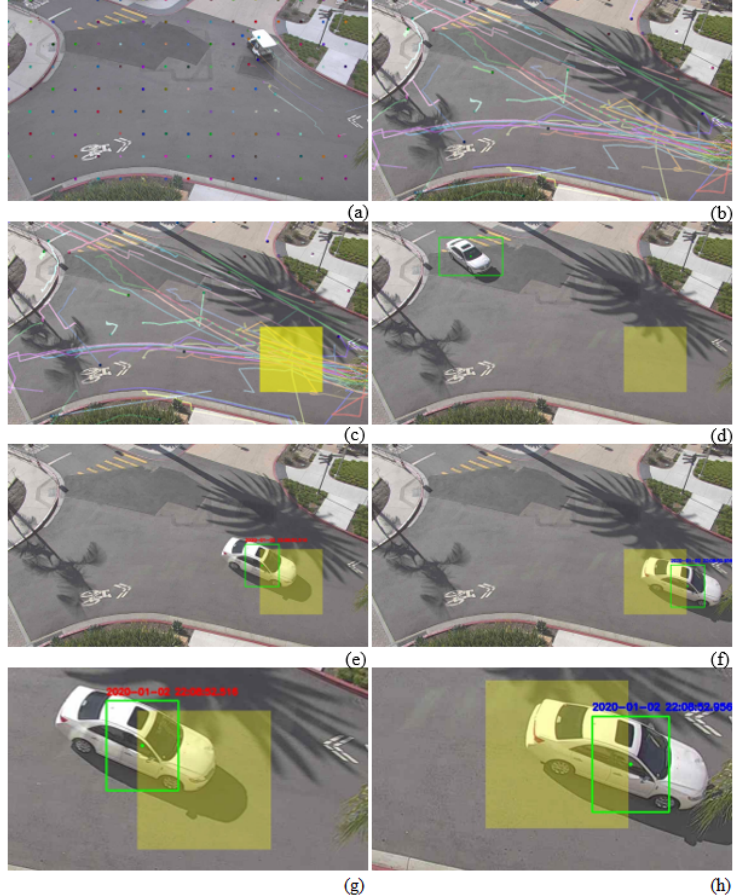
Figure 1. ( a ) Initial grid of feature points, ( b ) vehicle streamlines generated with OpenCV optical flow using the Lucas–Kanade estimation method, ( c ) superimposed artificially created conflict zone covering the area of greatest streamline number density, ( d ) vehicle being tracked, ( e ) vehicle centroid entering conflict zone at time 22:08:52.516, ( f ) vehicle centroid exiting conflict zone at time 22:08:52.956, ( g , h ) closer view showing conflict zone computed ingress and egress timestamps. Computed vehicle conflict zone residence time ∆ t = 956 ms − 516 ms = 440